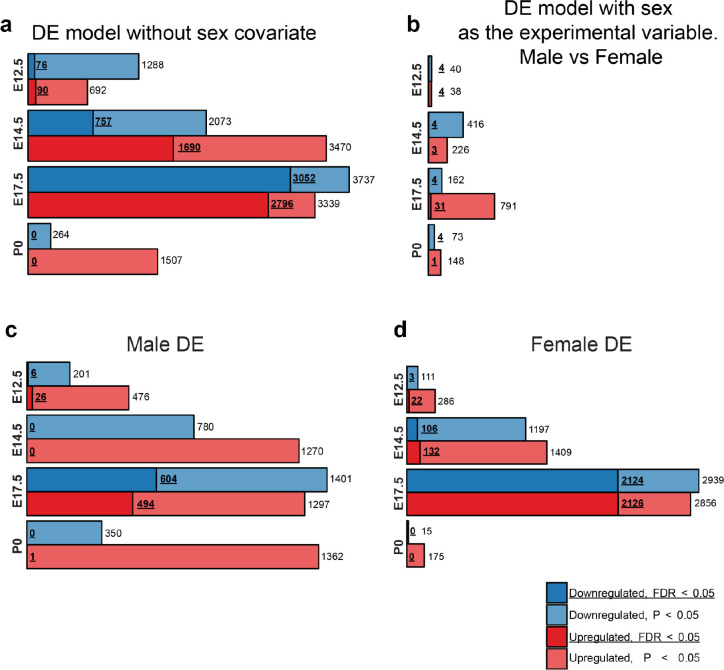
Males and females show largely concordant DE signatures following MIA.(a) Numbers of upregulated and downregulated DE genes with p < 0.05 and FDR < 0.05, in the DE analysis lacking the sex covariate, are similar to the DE model including the sex covariate (Figure 2c). (b) Numbers of upregulated and downregulated DE genes with p < 0.05 and FDR < 0.05, in a DE analysis testing for differential expression between sexes identifies few DE genes, suggesting limited sex dimorphism between samples. MIA conditions and sequencing lanes were set as covariates for the DE model. (c, d) Numbers of upregulated and downregulated DE genes with p < 0.05 and FDR < 0.05, for the DE analysis performed on (c) males and (b) females demonstrate robust DE at E17.5 in both sexes.